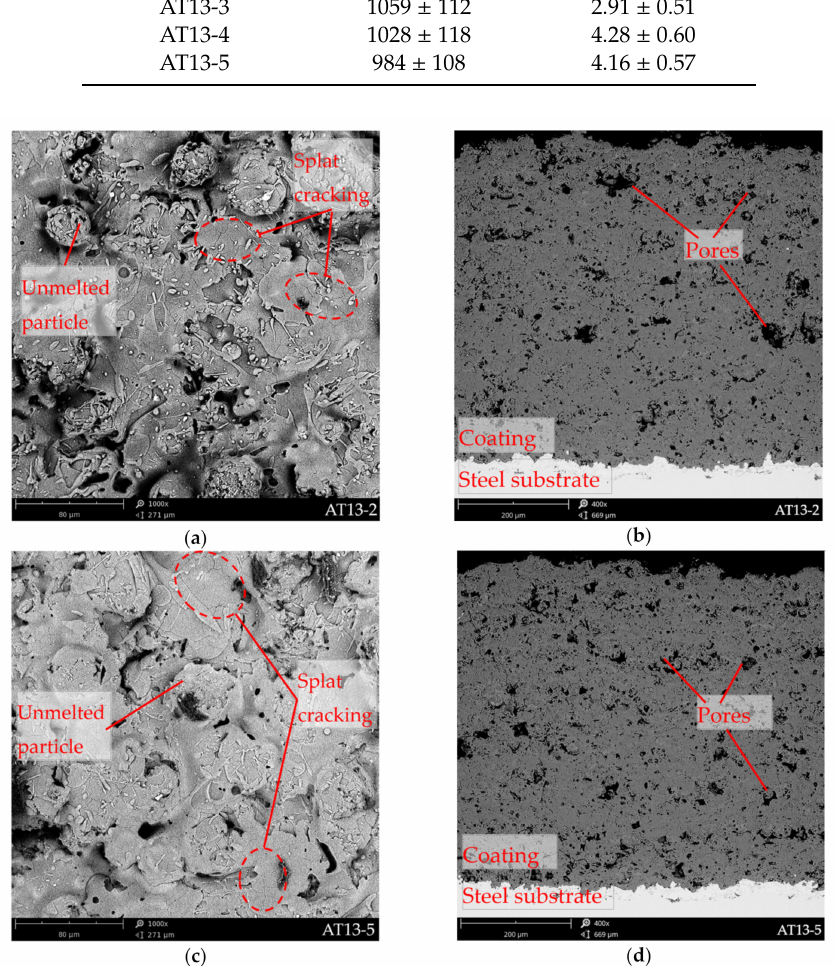
Figure 2. APS-deposited Al 2 O 3 -13 wt% TiO 2 coatings: surface morphology and cross section microstructure of AT13-2 ( a , b ) and AT13-5 ( c , d ),